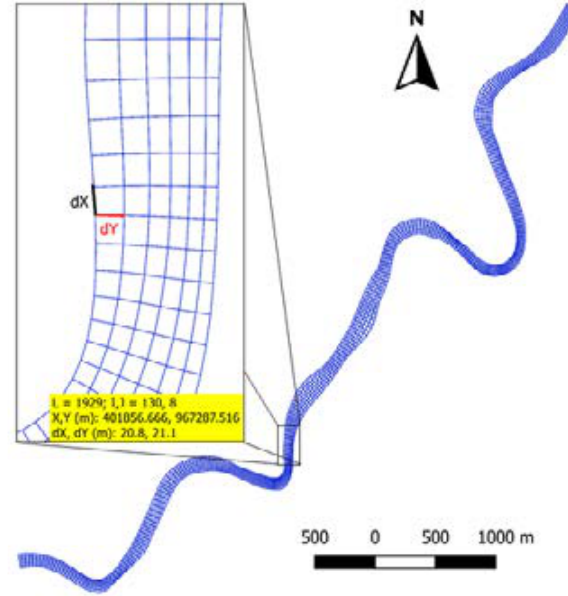
Fig. 2: Configuration of the generated grid